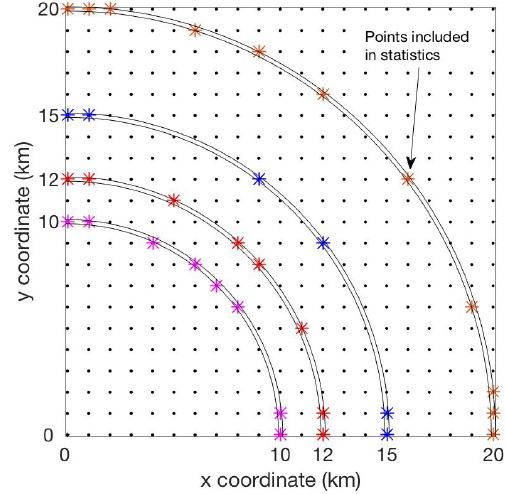
Figure 2. Virtual towers (black circles) in one quadrant of the LES domain horizontally spaced at 1km resolution. Selected virtual tow- ers are included in the analysis when they are within 100m of the reference radii: 10km (magenta), 12km (red), 15km (blue), and 20km (orange). Reference radii are measured from the hurricane